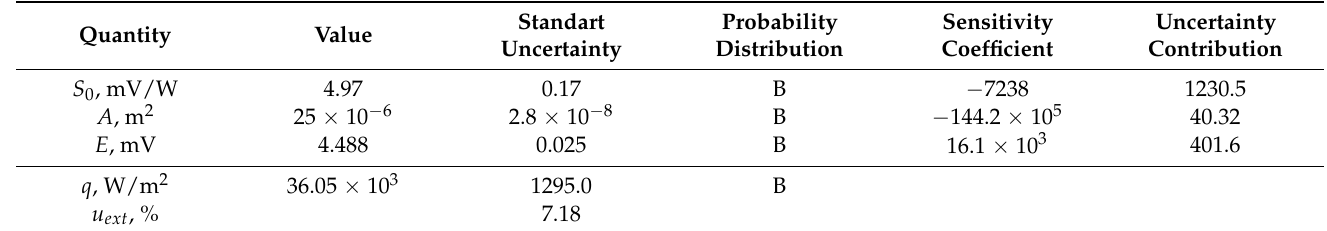
Table 1. The uncertainty budget for heat flux measurement (diesel flame; diesel mass flow rate G 3 = 7.95 kg/h; x = 125